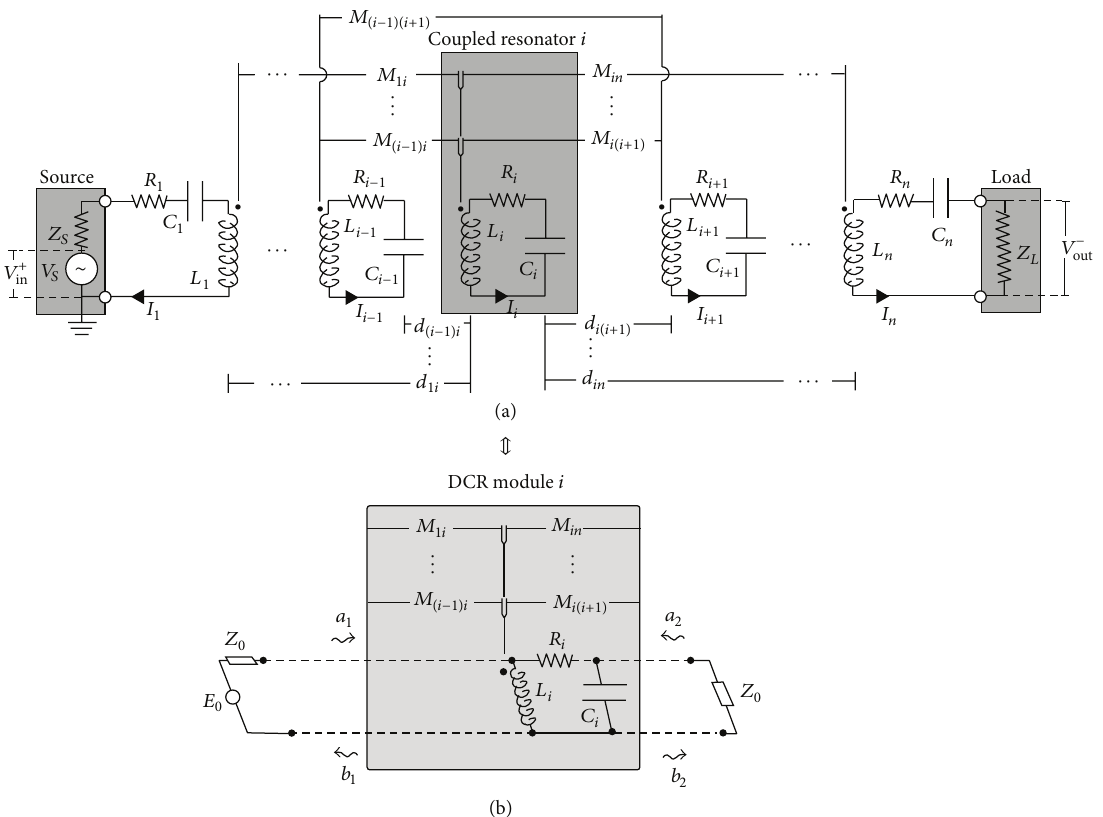
Figure 2: Typical DCR configuration with 𝑛 coupled resonators. (a) Equivalent circuit. (b) DCR module of approximate CSM